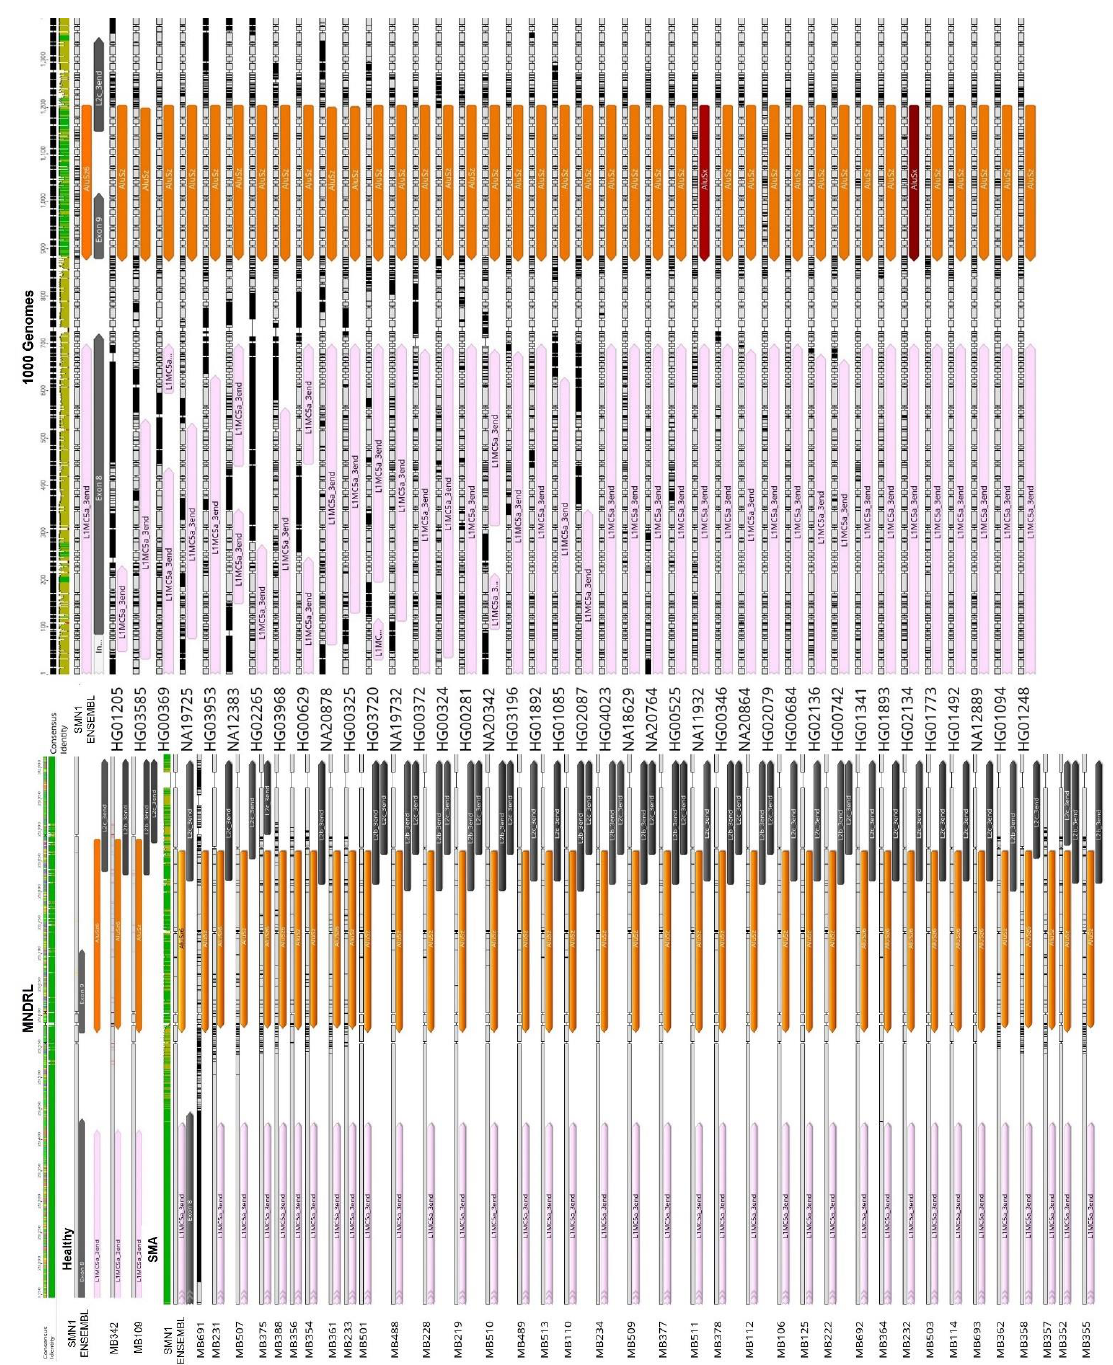
Figure 10. Comparison of the exon 9 region within the sample cohort. Extensive insertional poly- morphisms were detected for exon 9 region in the analyzed samples. While the expected AluSz insertion (represented by a light orange arrow) was present in some samples, other AluSz6 and AluSx insertions (represented by an orange arrow and a dark red arrow, respectively) were observed in this region. This polymorphism may be due to interpersonal variability and is not associated with SMA.